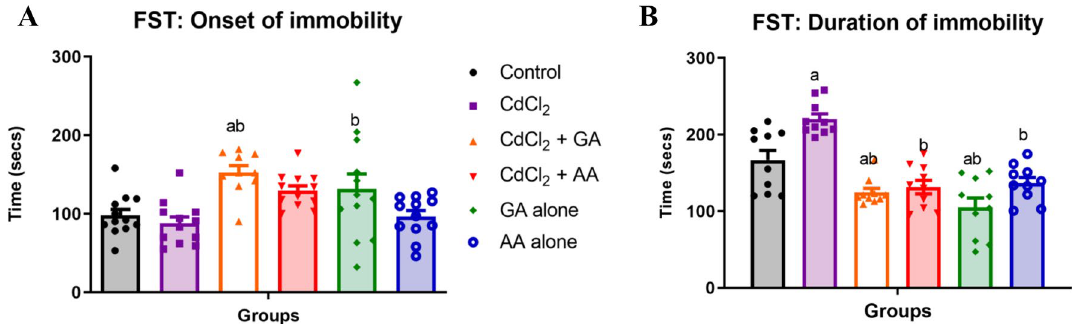
Figure 4. The effects of Gallic acid (GA) and ascorbic acid (AA) on CdCl 2 -induced depression. ( A ) is the onset of immobility. ( B ) is the duration of immobility. Values are presented as mean ± SD n = 12/group. a significant difference at p < 0.05 versus control, b significant difference at p < 0.05 versus CdCl 2